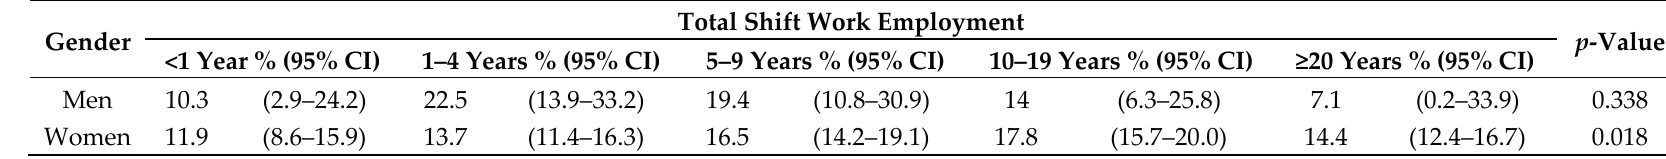
Table 5. Prevalence of wheeze by duration of shift